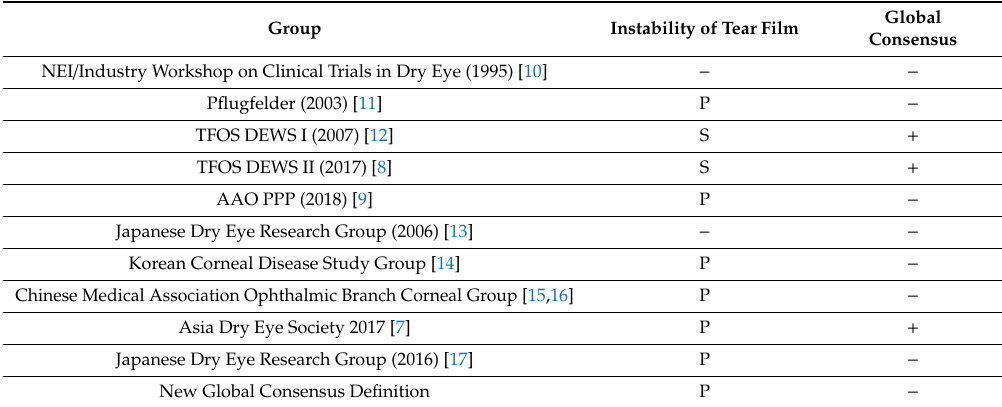
Table 1. Dry eye disease definitions proposed from 1995